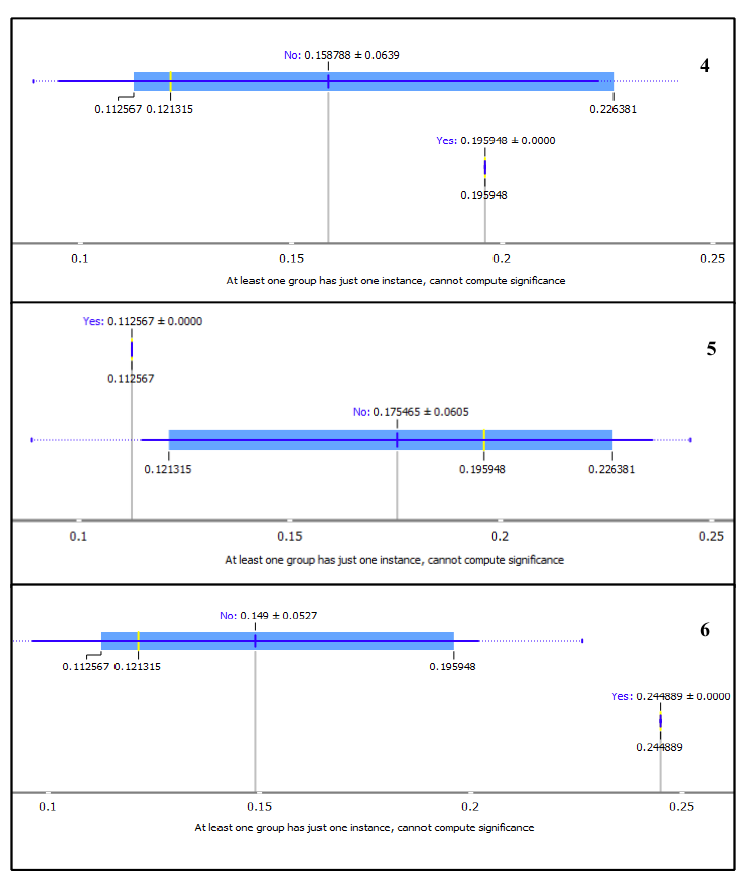
Figure 12. Box plots showing Marginal Topic Probability of the topics 4, 5 and 6 using Latent Dirichlet Allocation (LDA).